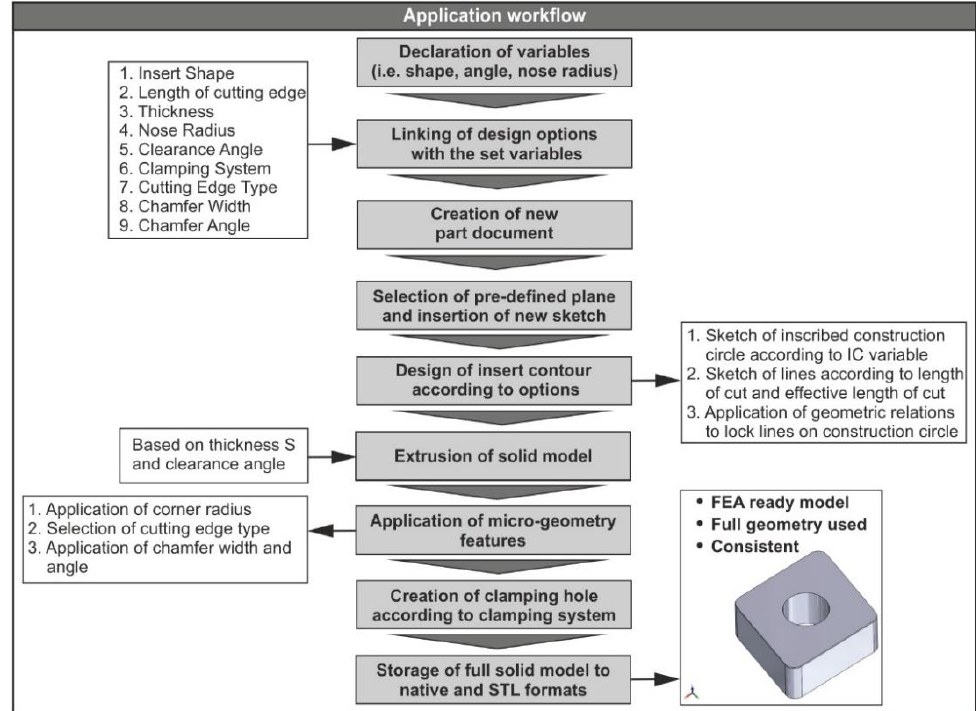
Figure 4. The application’s workflow.